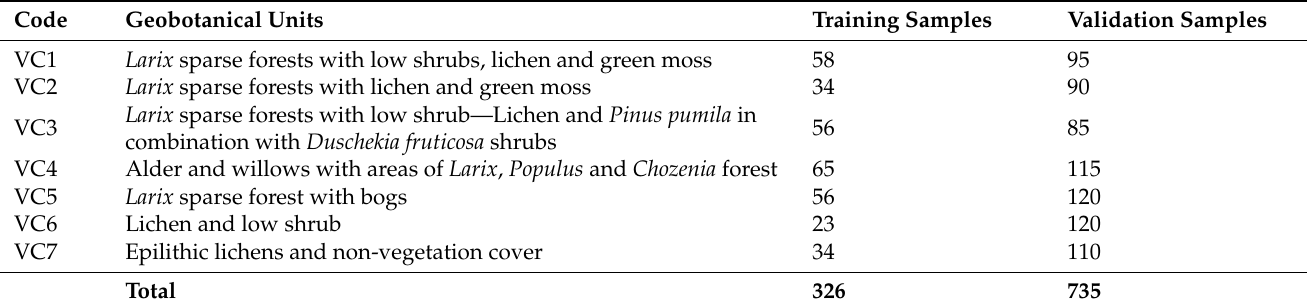
Table 3. Geobotanical units and sample data.